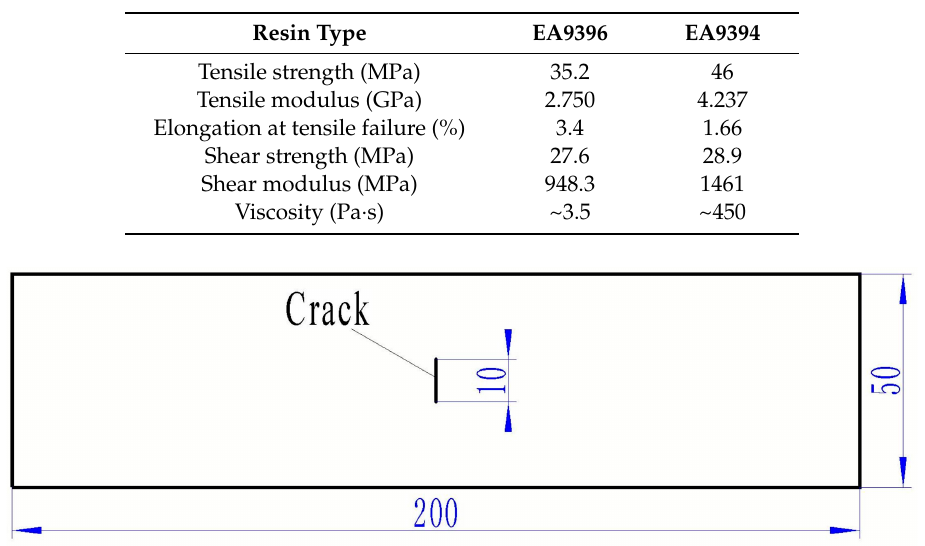
Figure 1. Geometrical configuration of Al plate with a generated crack. (Unit: mm).